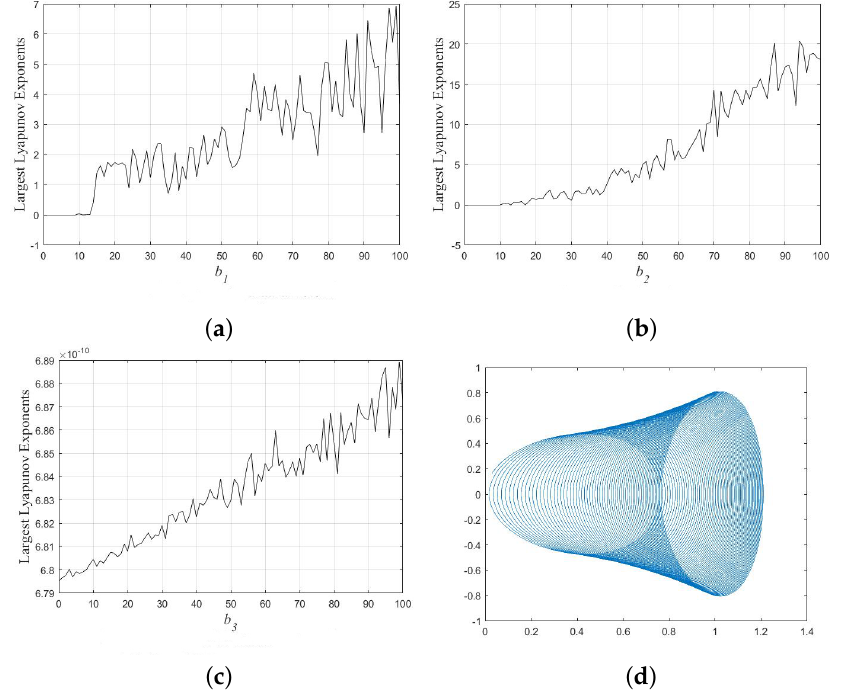
Figure 8. System (18): ( a ) largest Lyapunov Exponents for b 1 ; ( b ) largest Lyapunov Exponents for b 2 ; ( c ) largest Lyapunov Exponents for b 3 ; ( d ) Phase portrait when b 1 = − 0.983, b 2 = − 0.33, b 3 = − 0.987, b 4 = − 0.9, R 2 ( ξ ) = e 0.01 ξ